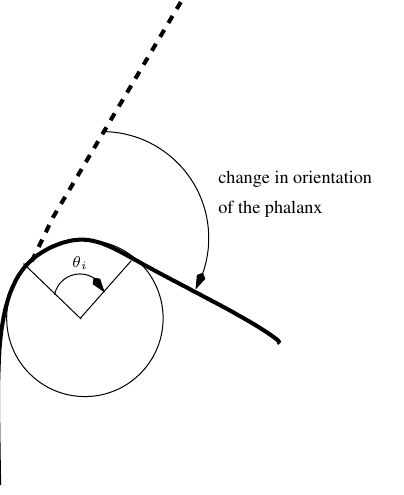
Fig. 3. ISOLATED ROTATION OF A JOINT FOR THE RETURN Figure 3. Isolated rotation of a joint for the return MECHANISM.